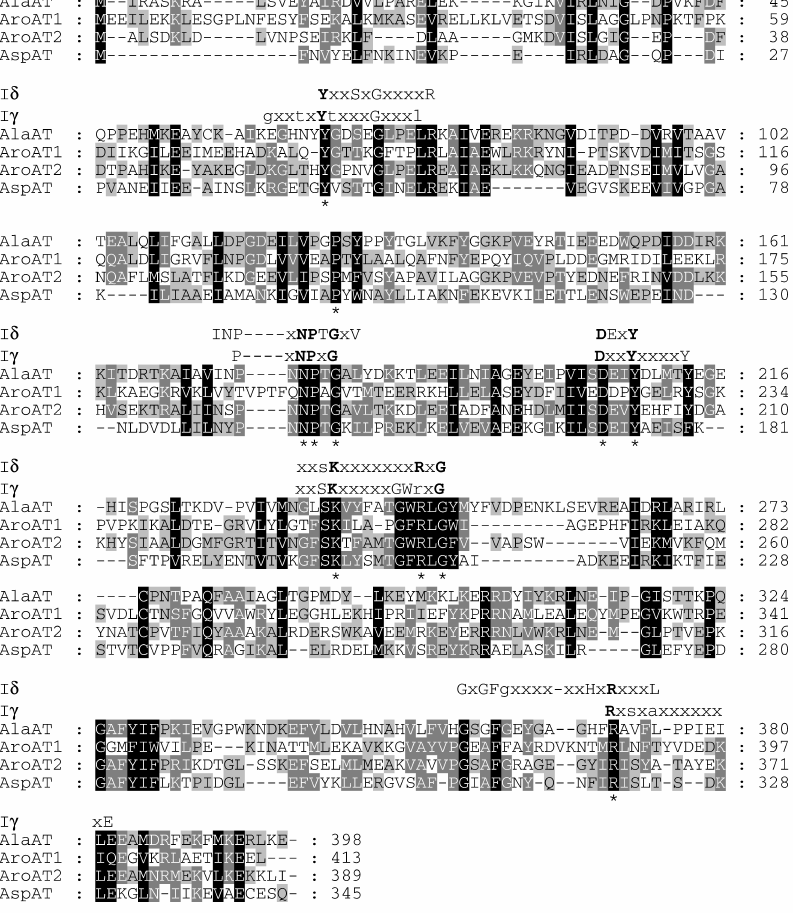
Figure 2. Multiple sequence alignment of P. furiosus AlaAT, AroAT I, AroAT II and AspAT. The alignment was performed with Clustal W. Invari- ant residues found within the subclass I aminotransferases are designated with an asterisk. The motifs associated with subfamilies I δ and I γ aminotransferases are also